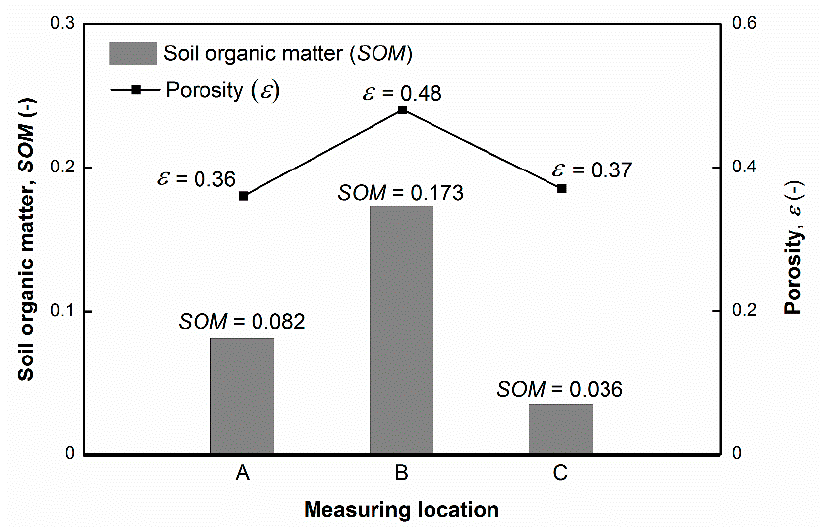
Figure 15. Soil organic matter ( SOM ) and porosity at three study locations (A, B, and C). Furthermore, the larger the SOM , the larger the fluctuation range of soil CO 2 flux at the same soil temperature. For example, at a temperature of 16 ◦ C, the soil CO 2 flux ranged from 0.910 to 2.583 µ mol · m − 2 · s − 1 and from 3.833 to 6.695 µ mol · m − 2 · s − 1 at Locations A and B, respectively, while less than 0.311 µ mol · m − 2 · s − 1 at Location C (Figure 14). Overall, soil CO 2 flux was significantly affected by the SOM of each soil location and the presence of plant roots and microorganisms.